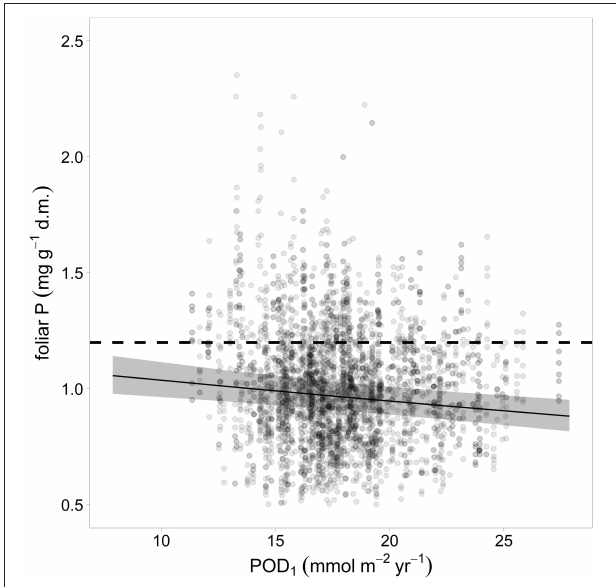
FIGURE 6 | Relation between ozone flux in the preceding year and foliar P. The gray bands indicate the 95% confidence interval. Ozone unit is Phytotoxic O zone Dose at Threshold 1 (POD1).